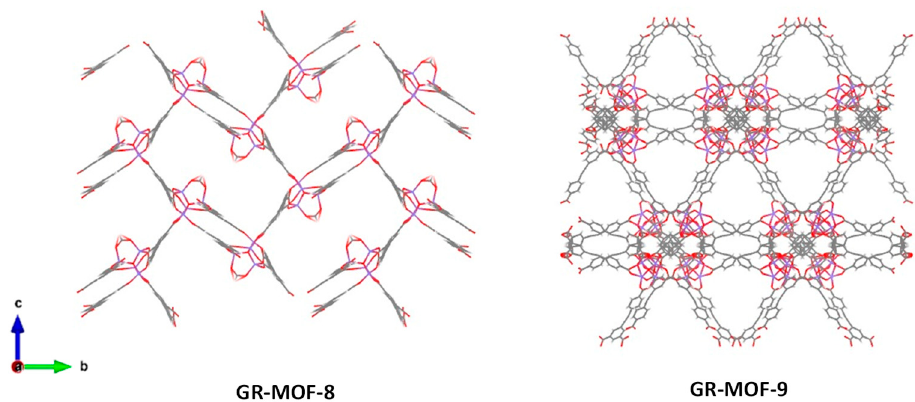
Figure 1. Three-dimensional representation of GR-MOF-8 and 9 along a axis. Zn, C, O and H are represented in blue, grey, red and white, respectively.